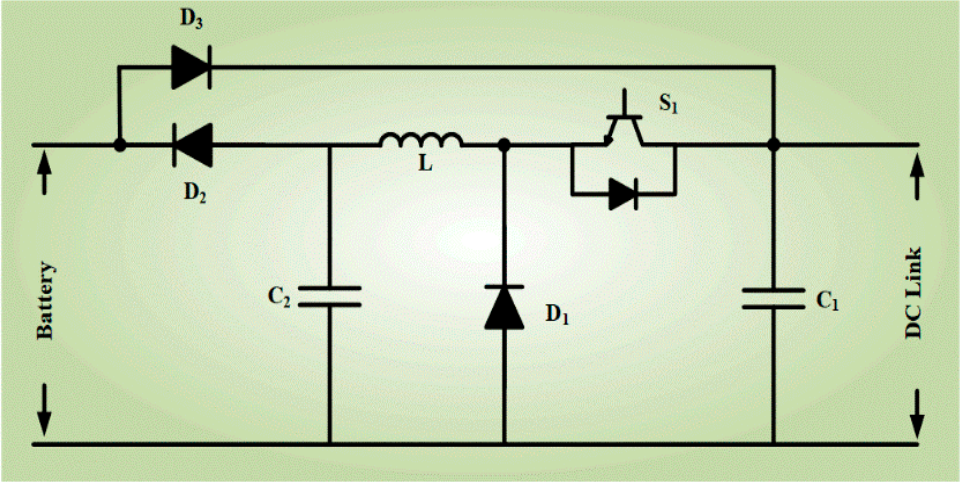
Figure 1. Battery charger based on a buck-chopper.